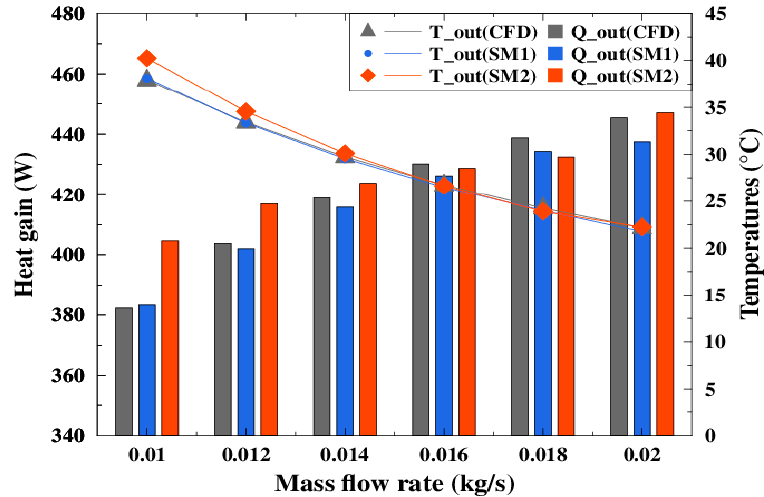
Figure 14. Variation in the temperature and heat gain of the air at the outlet with mass flow rate. To evaluate the results, the relative error was used as an indicator. The RE between CFD and the analytical results was calculated by: